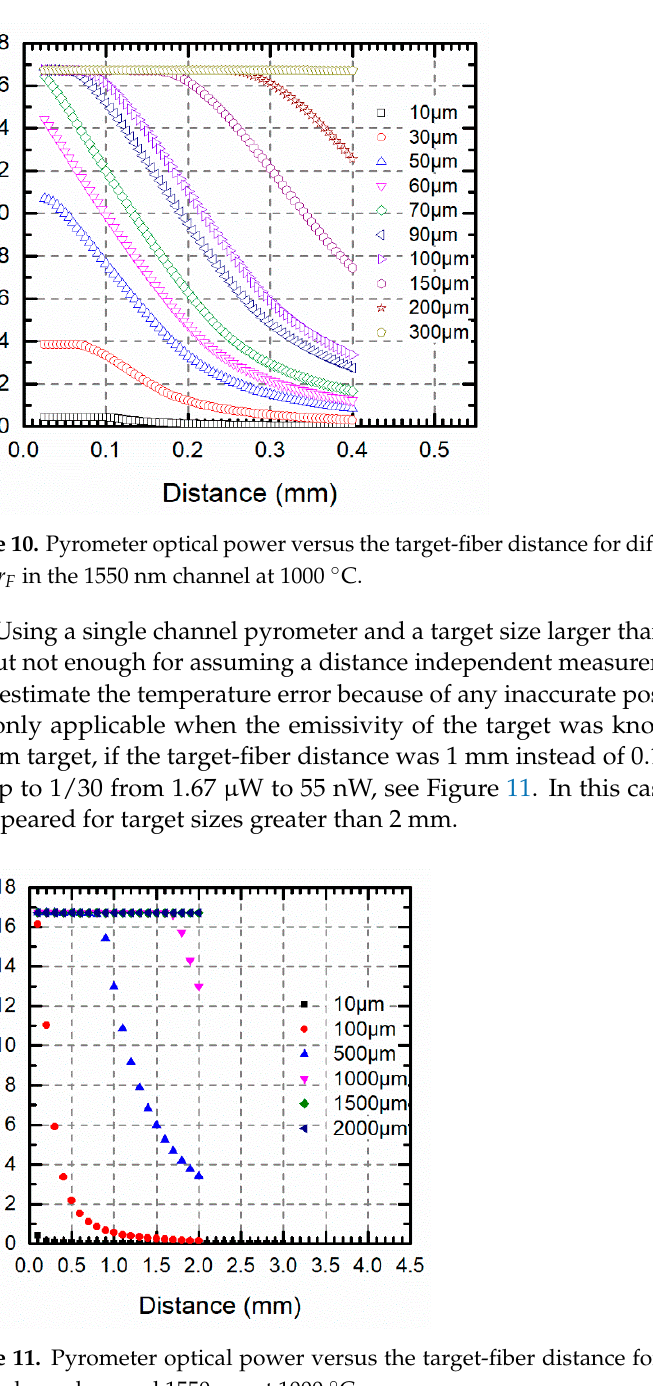
11 of 15 Figure 9. ( a ) Pyrometer optical power at 1550 nm versus the target-fiber distance for different target sizes at 1000 °C (black